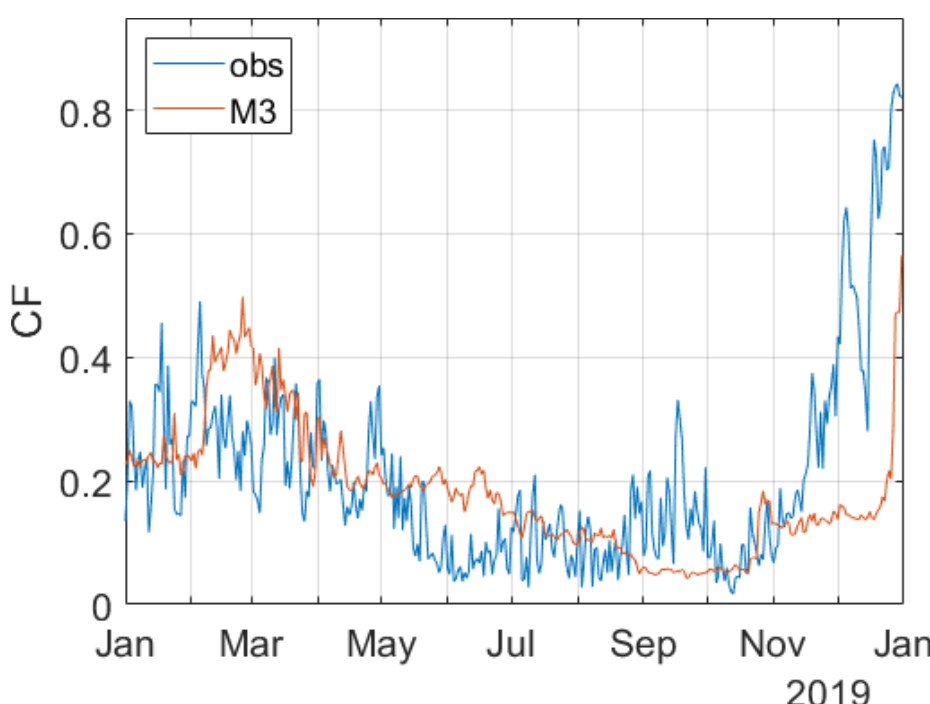
Figure 9. Time series of the observed and modeled capacity factor over the test year 2019, with training set over 2015–2018. (Figure 9 was modified according to the reviewers’comments). This observation seems to lead to the conclusion that for some countries the list of predictors should be enriched with more specific information, such as shares of energy, installed capacity, etc. This is left as a subject for future